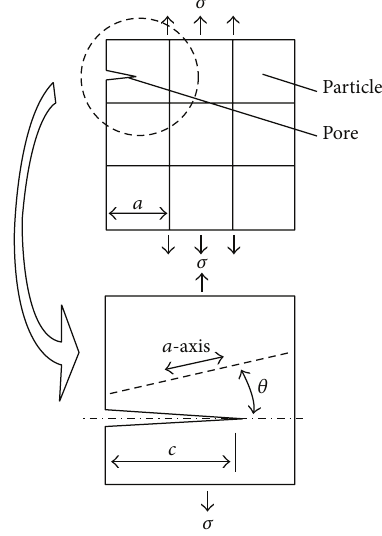
Figure 3: A graphite particle matrix containing particles and